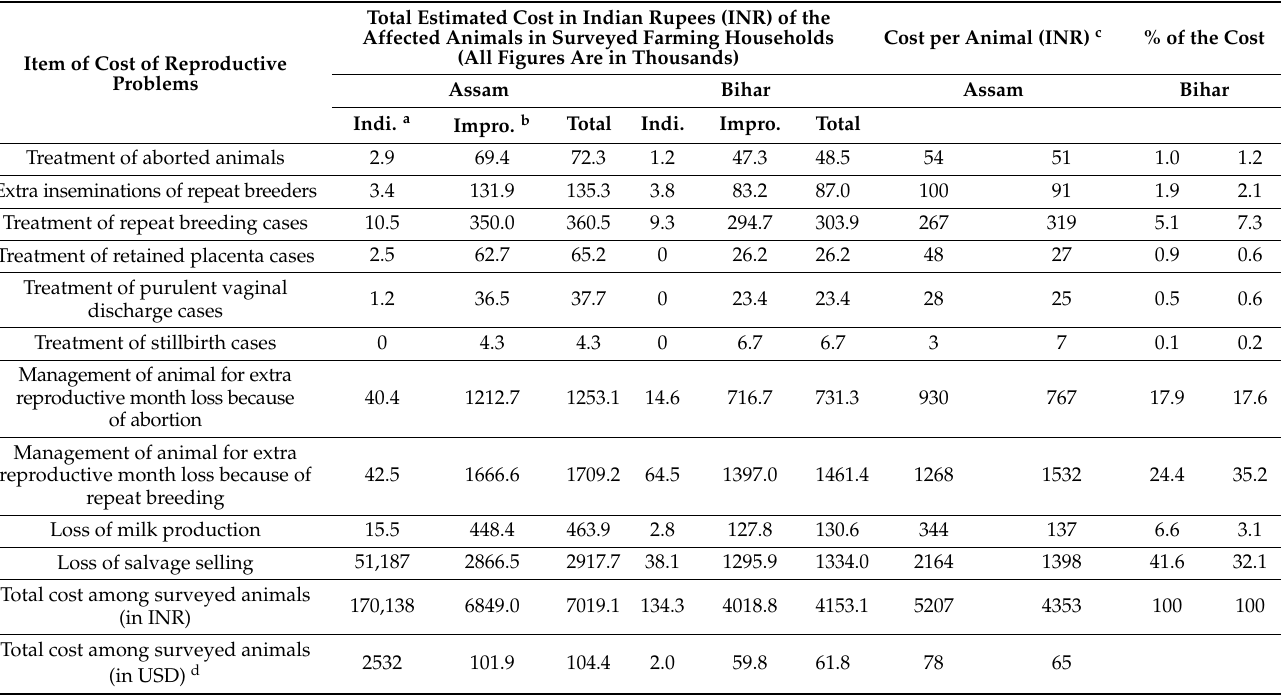
Table 3. Estimated cost of reproductive problems among the surveyed dairy farming households in Assam and Bihar. Total Estimated Cost in Indian Rupees (INR) of the Affected Animals in Surveyed Farming Item of Cost of Reproductive Problems